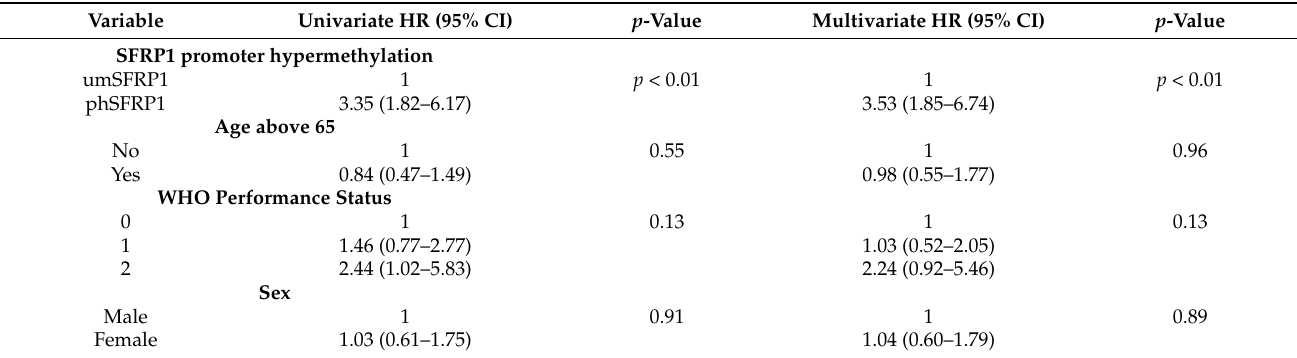
Table 4. Univariate and multivariate Cox regression analysis in patients from the validation cohort.